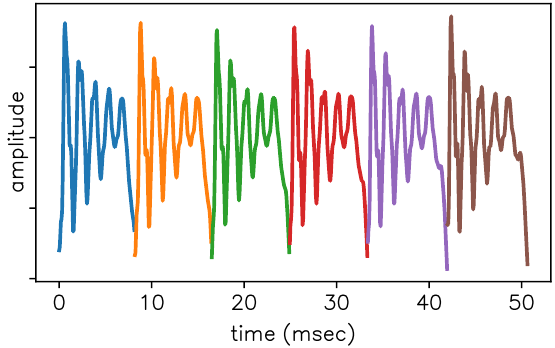
Figure 3. A model of the SSV (in this case an / E /, which is also used in the next section) consists of several model functions f ( t ; P , Q , A i , k , B i , j , C i , j , Ω ) strung together, as shown in this plot by giving each such model function its own color. The model functions are fitted to the individual pitch periods but are “frustrated” by their having to share the formant frequencies and decay constants Ω